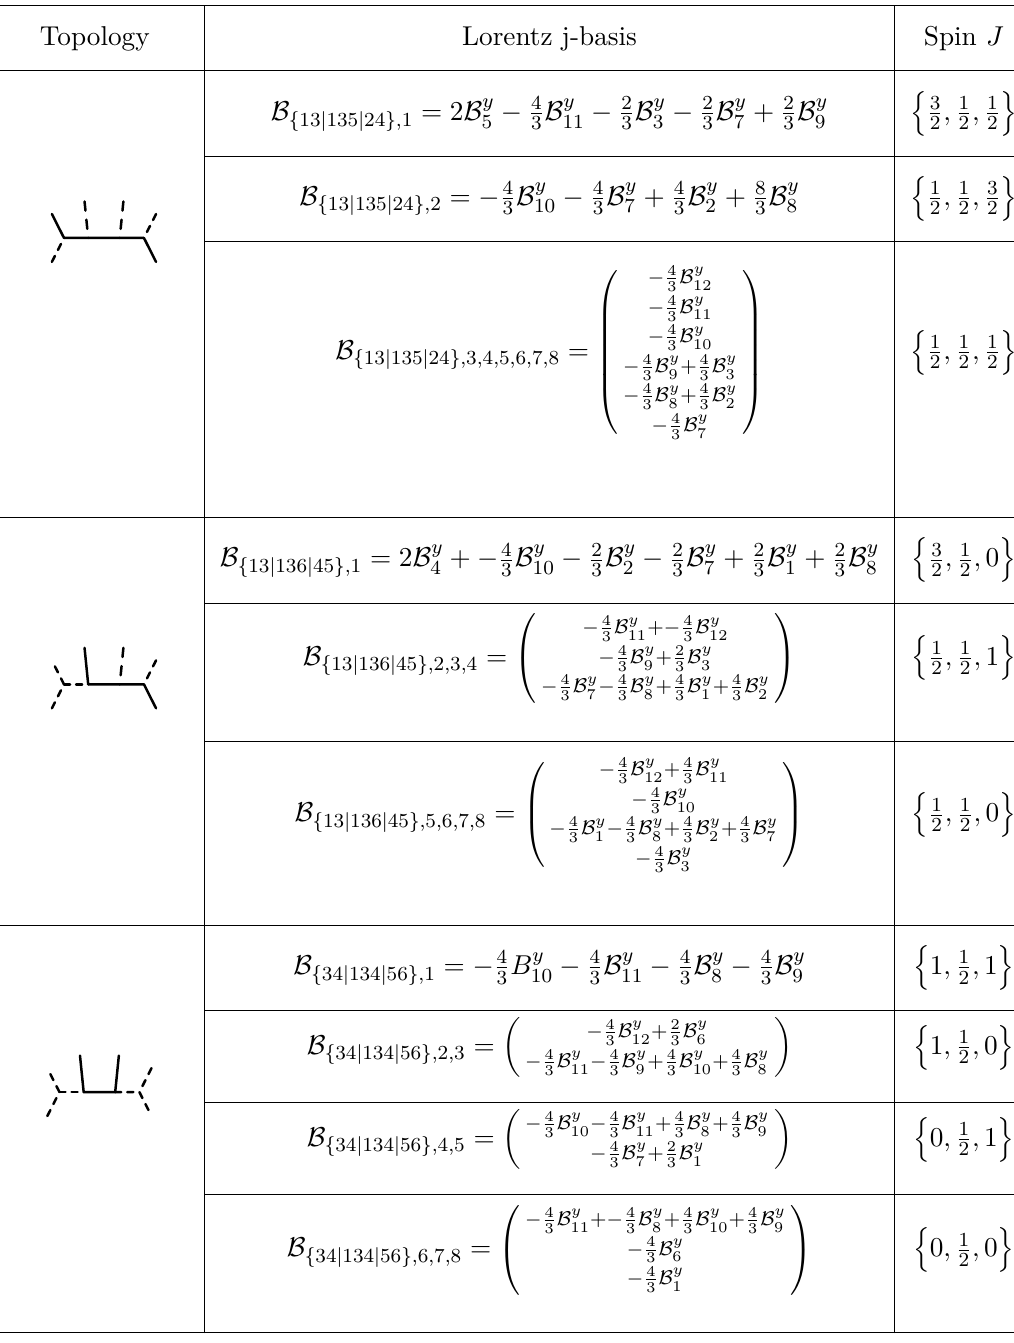
Table 14 . The j-basis of the type L 2 H 3 H † D 2 for three different kinds of topologies. Note that the last column only labels the spin of the three internal